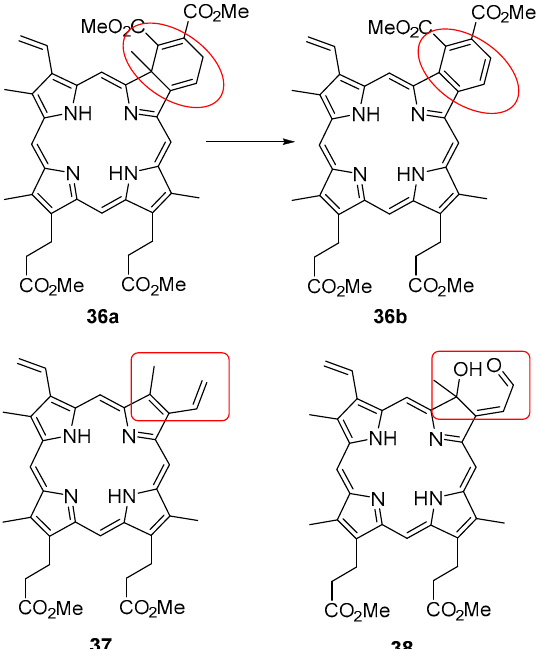
Figure 12. Protoporphyrin-IX dimethyl ester and adducts obtained in Diels-Alder reactions with singlet oxygen and dimethyl acetylenedicarboxylate (DMAD) [119,122,124,125]. Molecules 2017 , 22 , 1269 19 of 44